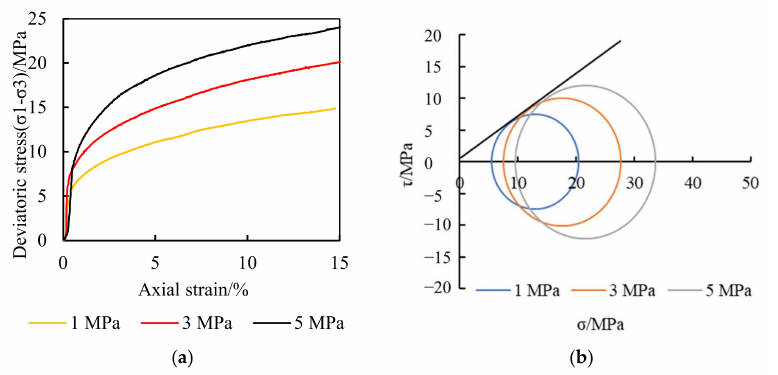
Figure 18. Stress-strain curve and Mohr circle of rock samples of the marine NGH reservoir. ( a ) is the stress-strain curve of rock samples; ( b ) is the mohr circle of rock